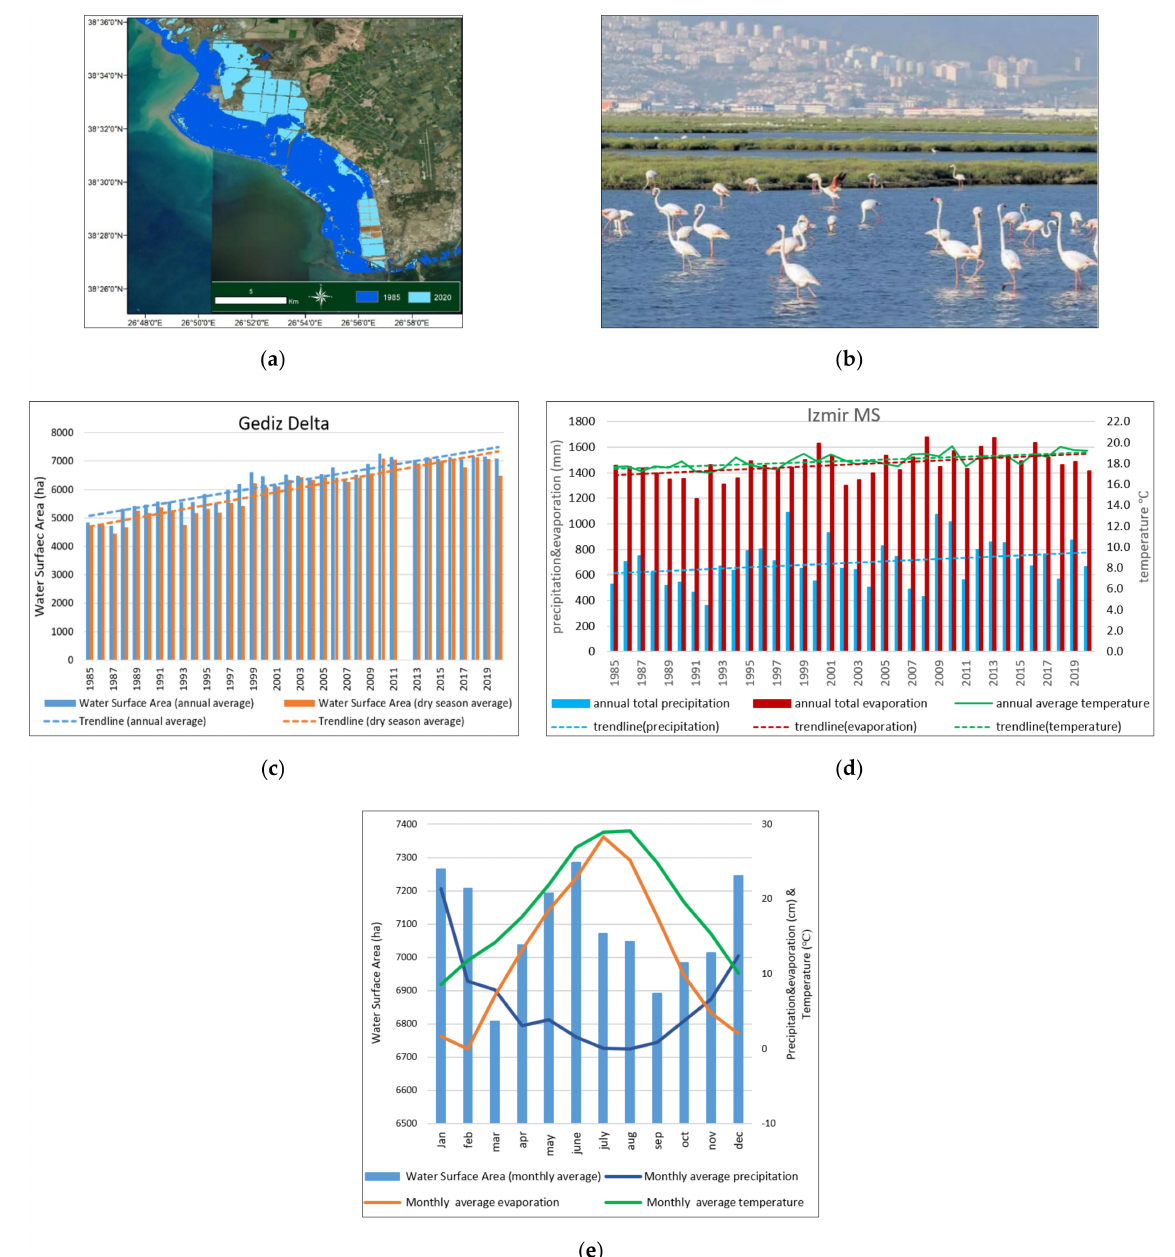
Figure 6. Gediz Delta: ( a ) Delta Location and 1985 And 2020 Annual Average Water Surface Areas (NDWI > 0); ( b ) View of Delta [52]. ( c ) 1985–2020 Period, Water Surface Areas (Annual Averages and Dry Season Averages); ( d ) Izmir Meteorological Station Data (Annual Total Precipitation, Total Evaporation, and Average Air Temperature); ( e ) 2016–2020, Monthly Average Water Surface Areas, Precipitation, Evaporation and